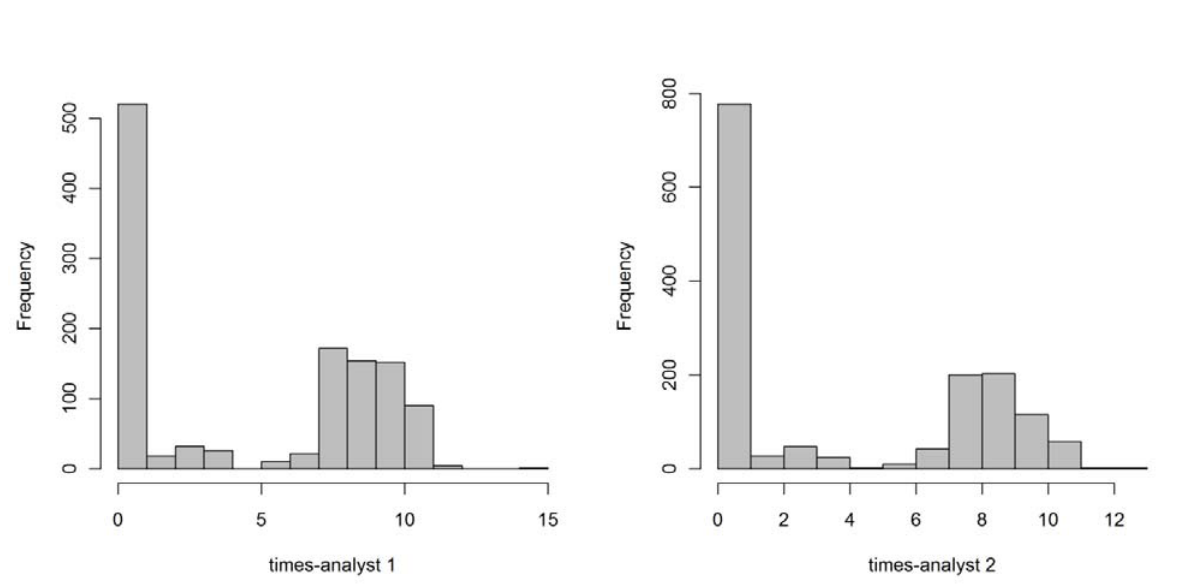
Fig. 1. Histograms for the test times considering the two analysts.